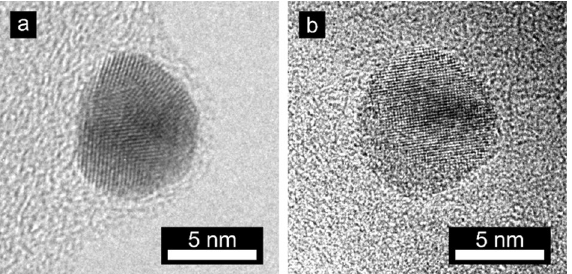
Figure 2. HRTEM image of aerosol-generated nano-particles: ( a ) gold nanoparticle; ( b ) palladium nanoparticle.